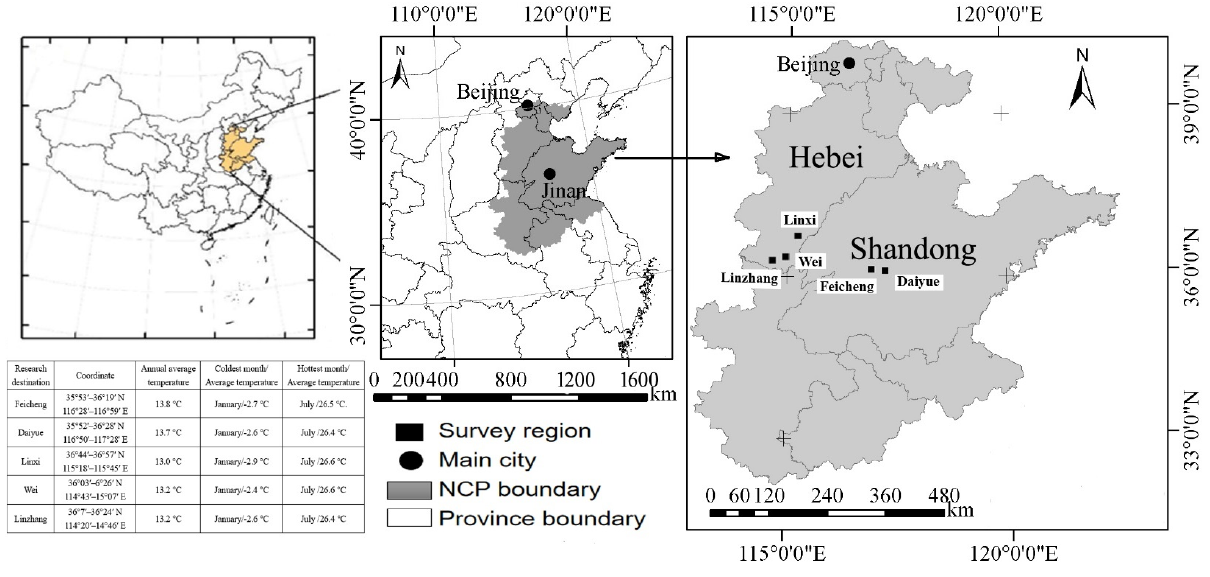
Figure 1. The investigated regions.